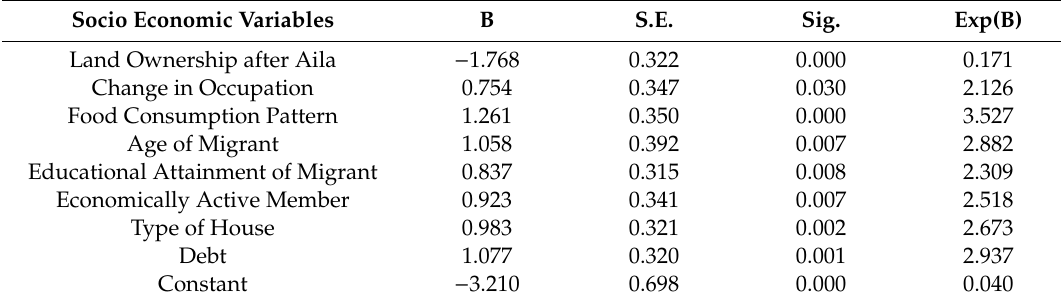
Table A2. Logistic